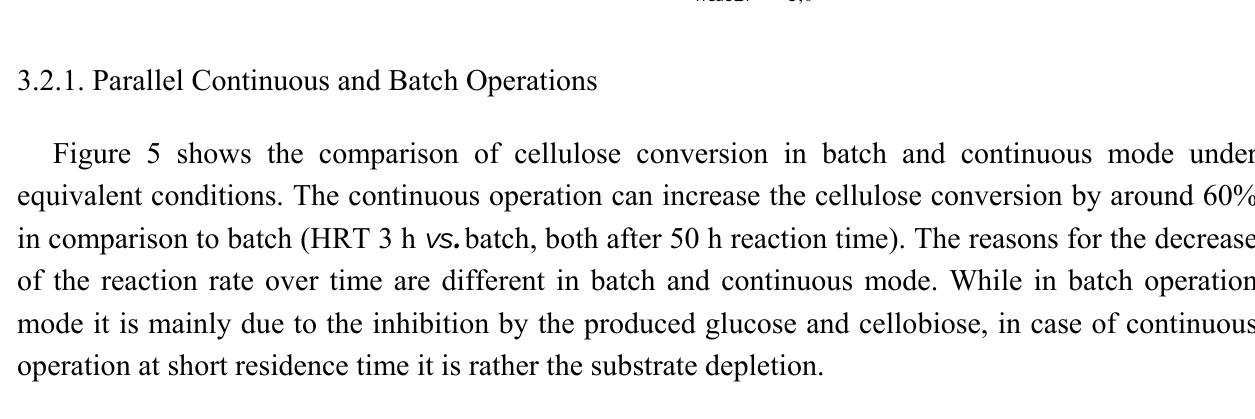
Figure 5. Cellulose conversion during parallel batch and continuous operations with different hydraulic residence times (HRT) from 3 to 12 h; c T = 40 °C, pH = 4.66, n = 100 min − 1